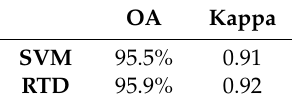
Table 4. The overall accuracy (OA) and Kappa coe ffi cient of the Support Vector Machine (SVM) and Real-Time-Di ff erence (RTD) methods for the Hainan images.